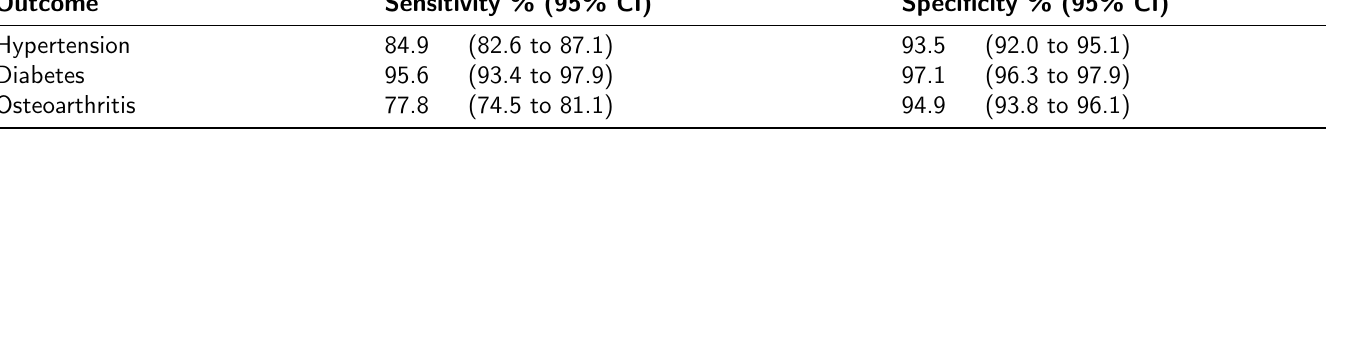
Appendix Table 2: Outcome